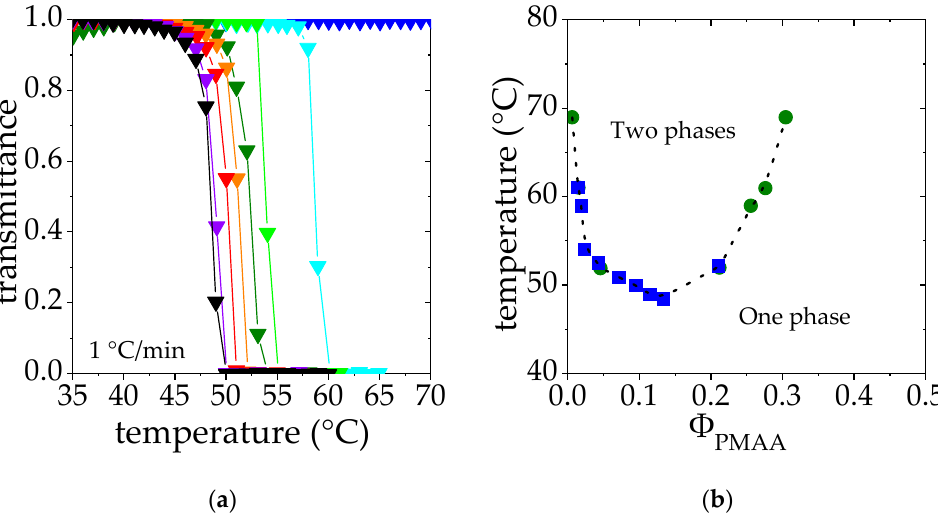
Figure 2. ( a ). Transmittance measurements of PMAA solution at different PMAA volume fraction Φ PMAA : ▼ 0.005, ▼ 0.019, ▼ 0.028, ▼ 0.047, ▼ 0.075, ▼ 0.0950, ▼ 0.115, ▼ 0.134. ( b ). Cloud point temperature as a function of the PMAA volume fraction determined through transmittance measure- ments ■ . These data are superimposed on the phase diagram derived from the phase concentration measurements ● . Dashed line is a “guide for the eyes”.